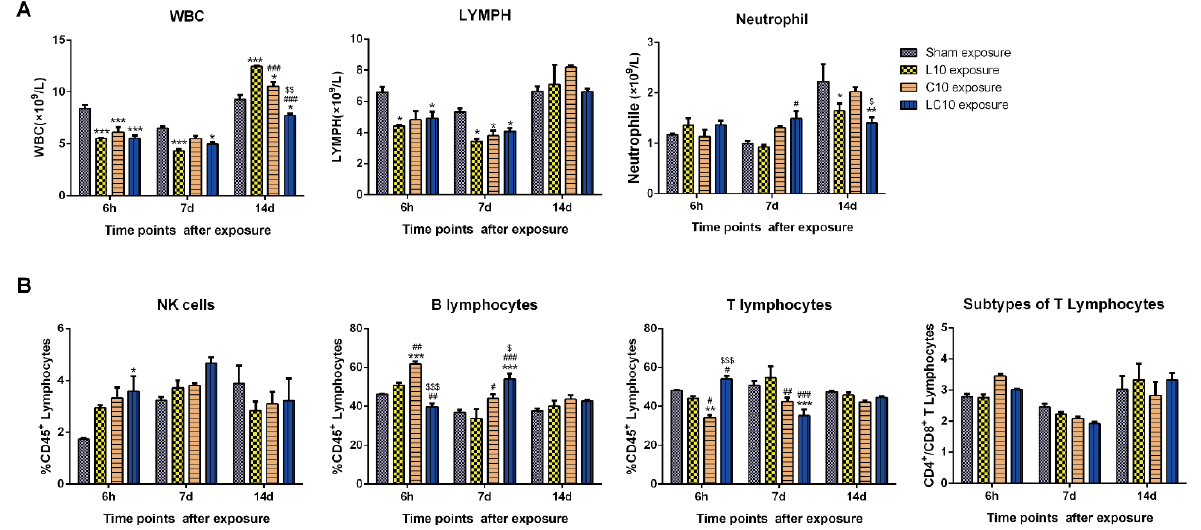
Figure 2. Microwave dynamically regulated immune cells in peripheral blood of rats. At 6 h, 7 d and 14 d after exposure to 10 mW/cm 2 microwaves, the rats in the sham (Sham) group, L band (L10) group, C band (C10) group and compound bands (LC10) microwave exposed groups were anaesthetized by pentobarbital sodium and the peripheral blood was collected from inferior vena cava (IVC). The immune cells in peripheral blood, including white blood cells (WBC), neutrophils, and lymphocytes (LYMPH), were counted by automatic blood cell counter ( A ). Moreover, the percentage of natural killers (NK) cells, B lymphocytes, T lymphocytes among LYMPH, as well as the ratio of CD4 + T lymphocytes to CD8 + T lymphocytes, were analyzed by flow cytometry ( B ). Data were shown as mean ± s.e.m. *, p < 0.05, **, p < 0.01, ***, p < 0.001 vs. Sham group; #, p < 0.05, ##, p < 0.01, ###, p < 0.001 vs. L10 group; $, p < 0.05, $$, p < 0.01, $$$, p < 0.001 vs. C10 group.